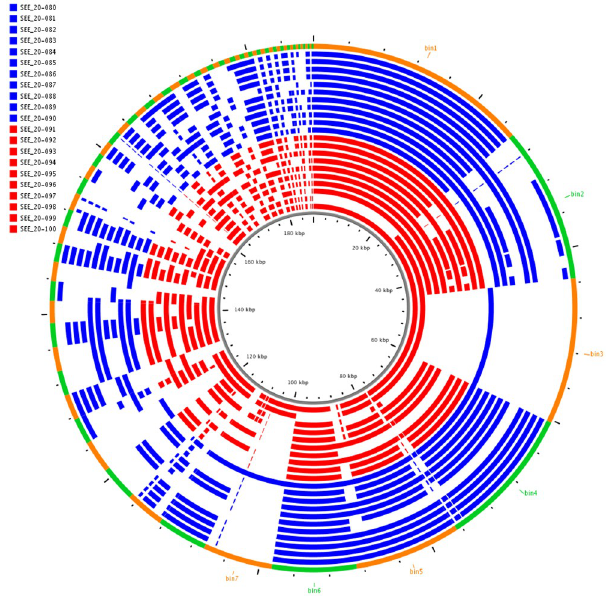
Fig 2. Comparison of accessory genome elements (AGE) of inapparent carrier SEE (n = 11), and acute clinical SEE (n = 10) genomes from Pennsylvania. The outer ring shows the ClustAGE bins that are � 200 base-pairs in size these are ordered clockwise from the largest bin to the smallest bin, and are differentiated by orange and green to define bin borders. The concentric inner bands show the distribution of AGE within each individual isolate. Bands that are blue represents inapparent carrier isolates, and bands that are red represent acute clinical isolates. The central ruler of the figure indicates the cumulative size of the AGE in kilobases.